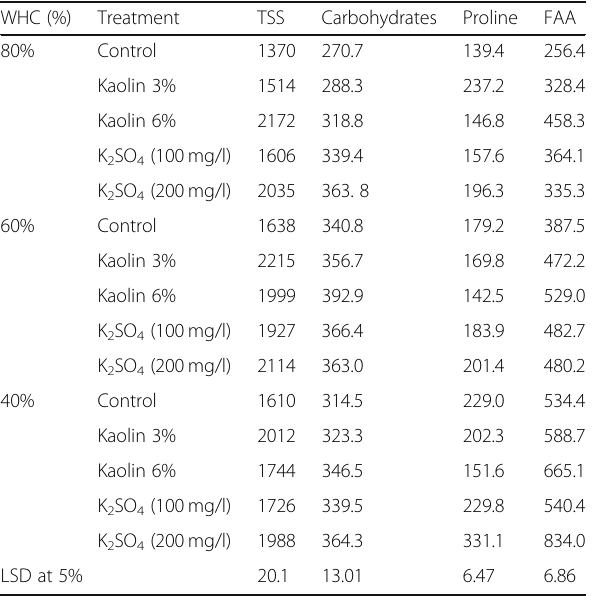
2 SO 4 Table 5 Effect of different concentrations of kaolin or K under different levels of water holding capacity on